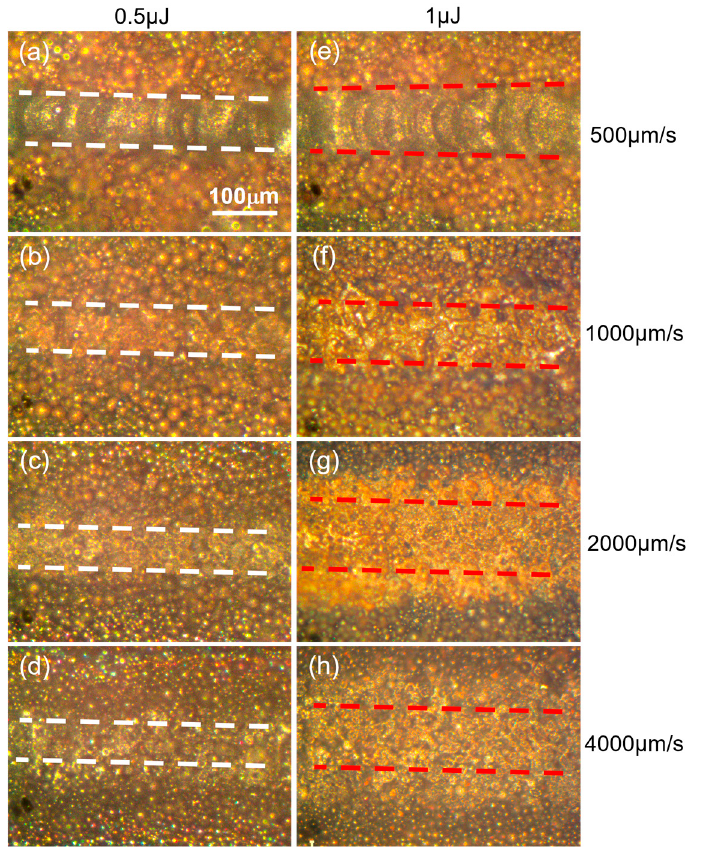
Figure 3. Effects of scanning velocity and pulse energy on the morphology revolution of single track at repetition of 500 kHz: ( a – d ) 0.5 μ J, ( e – h ) 1 μ J. All scale bars = 100 μ